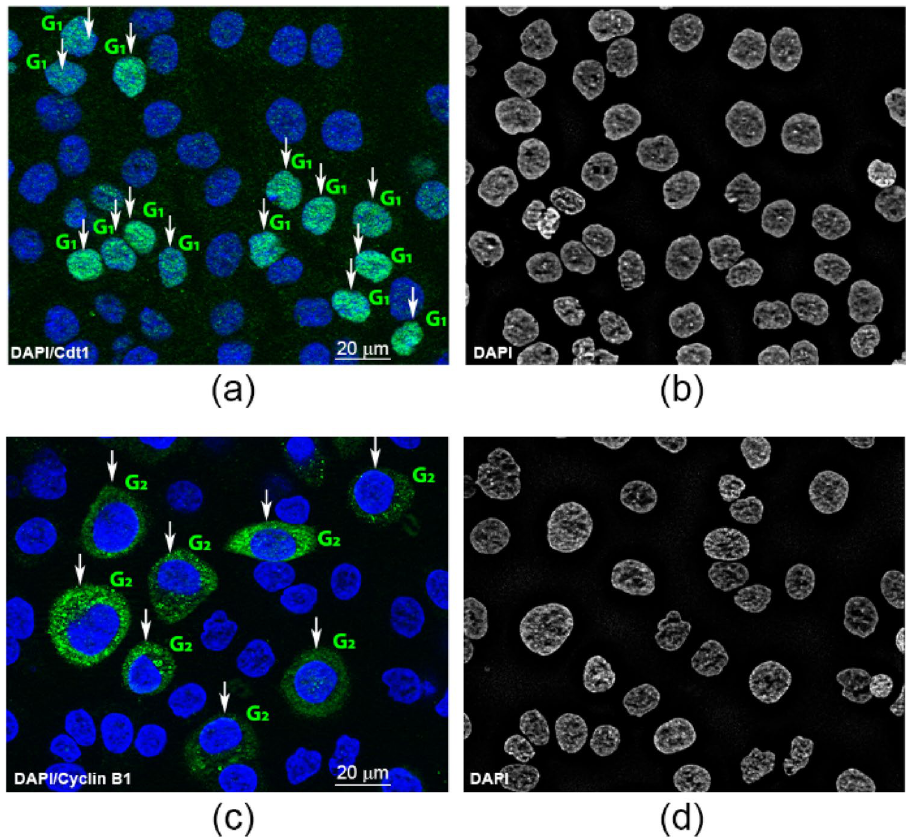
Figure 6. Method applicability in immunofluorescence images of gastric cancer cells. Human gastric cancer cells AGS were stained with Cdt1 (green) (a) or cyclin B1 (green) (c) and counterstained with DAPI (blue). White arrows indicate cells considered positive for Cdt1 or cyclin B1 expression and used for further analysis and G 1 and G 2 denotes the labels obtained after automatic classification based on DAPI staining. (b,d) Corresponding DAPI images used for cell cycle